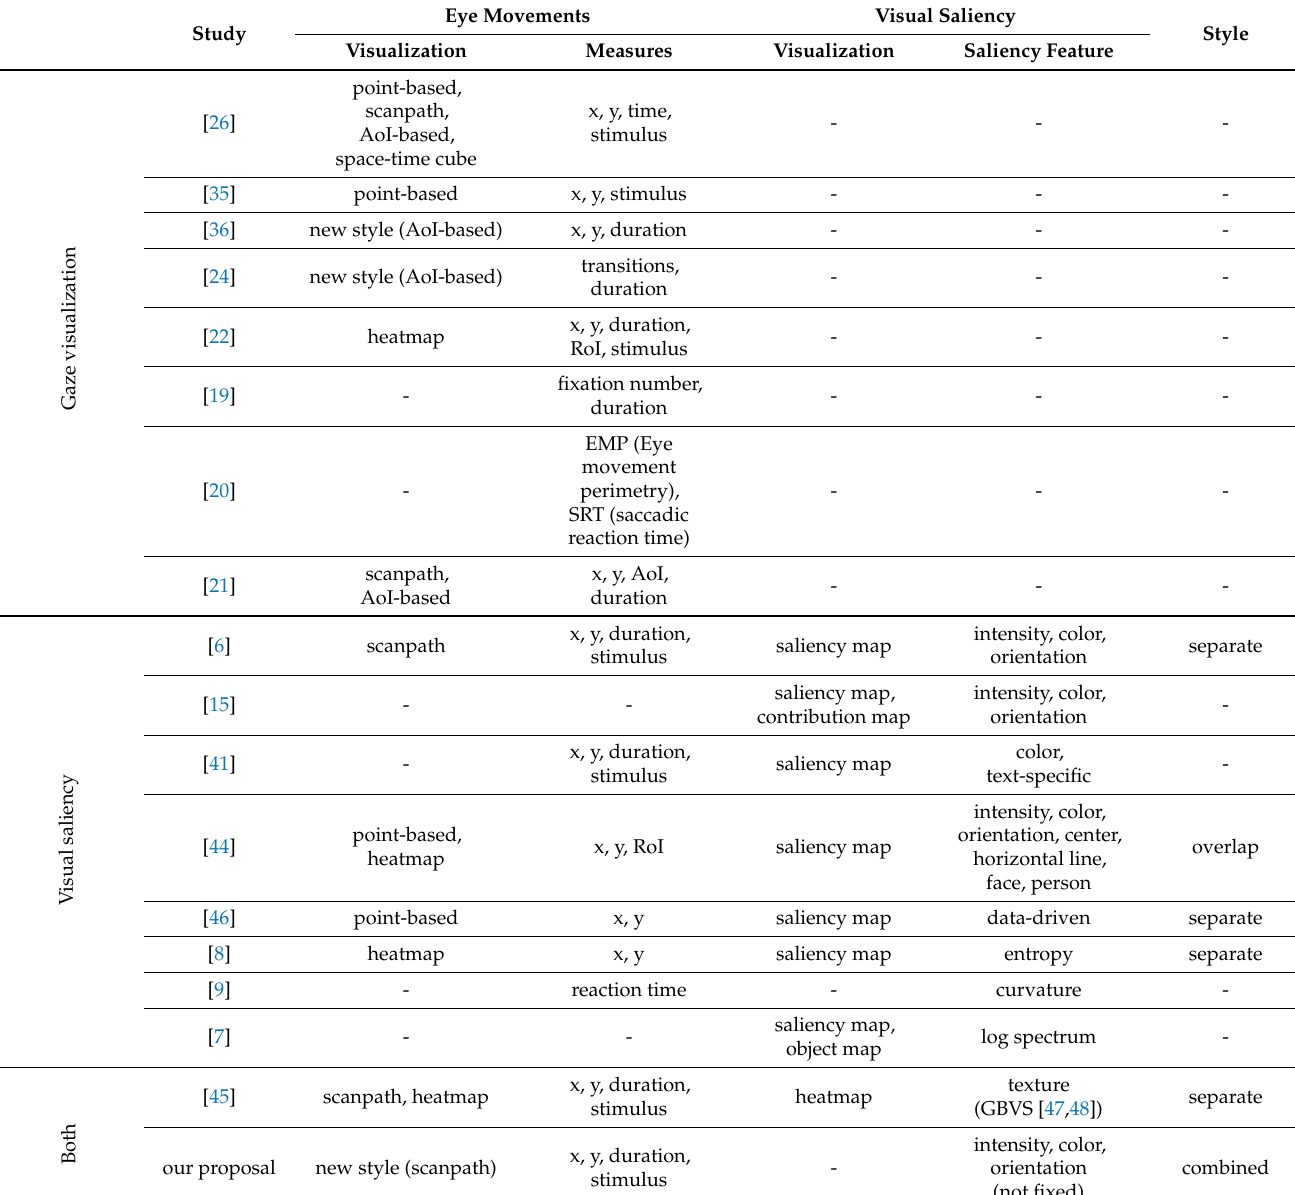
Table 1. Summary of related studies. The table shows the eye movements data visualization and measures, visual saliency visualization and features, and visualization style used in each